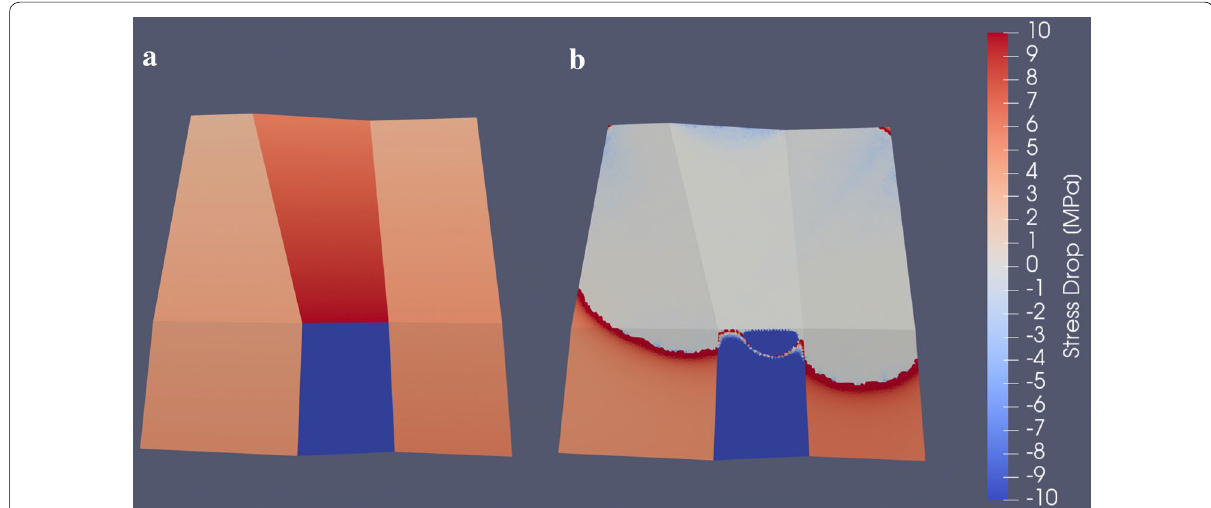
Fig. 10 On-fault distribution of potential stress drop for model 5 before ( a ) and after the dynamic rupture event ( b ) (view from the